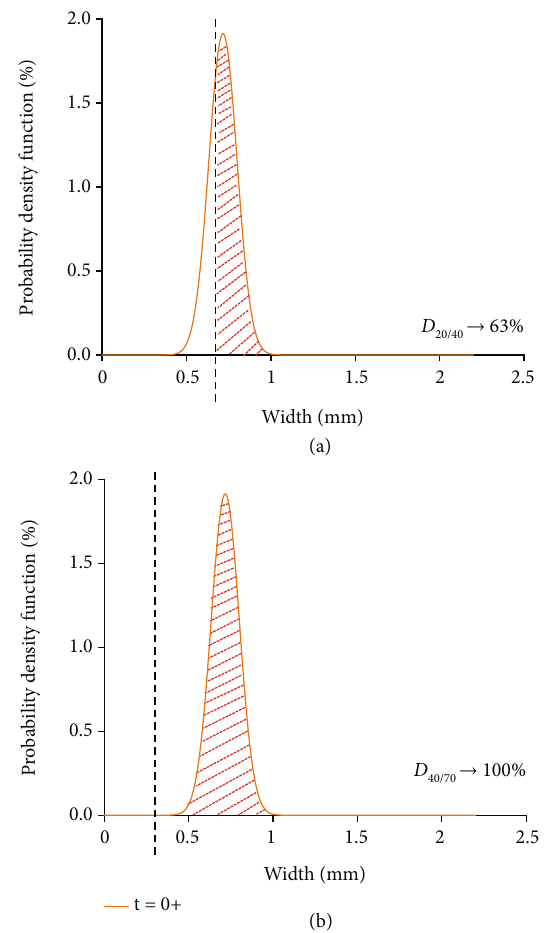
Figure 16: PDF of the fracture width at t = 0 + . The probability of the proppant to fi t inside the created fracture width is represented by the hashed area. The success rate of 63% for D 20/40 and of 100% for D 40/70 .